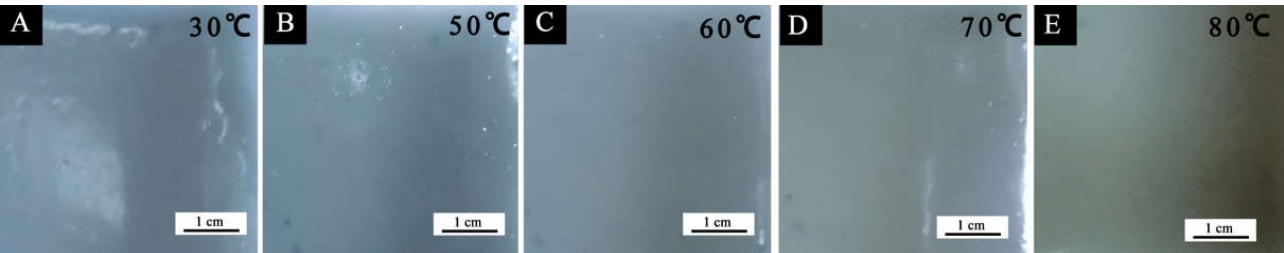
Figure 6. Color changes in the alkyd resin film with photochromic microcapsules and thermochromic microcapsules during the heating process: ( A ) 30 °C; ( B ) 50 °C; ( C ) 60 °C; ( D ) 70 °C; ( E ) 80 °C.